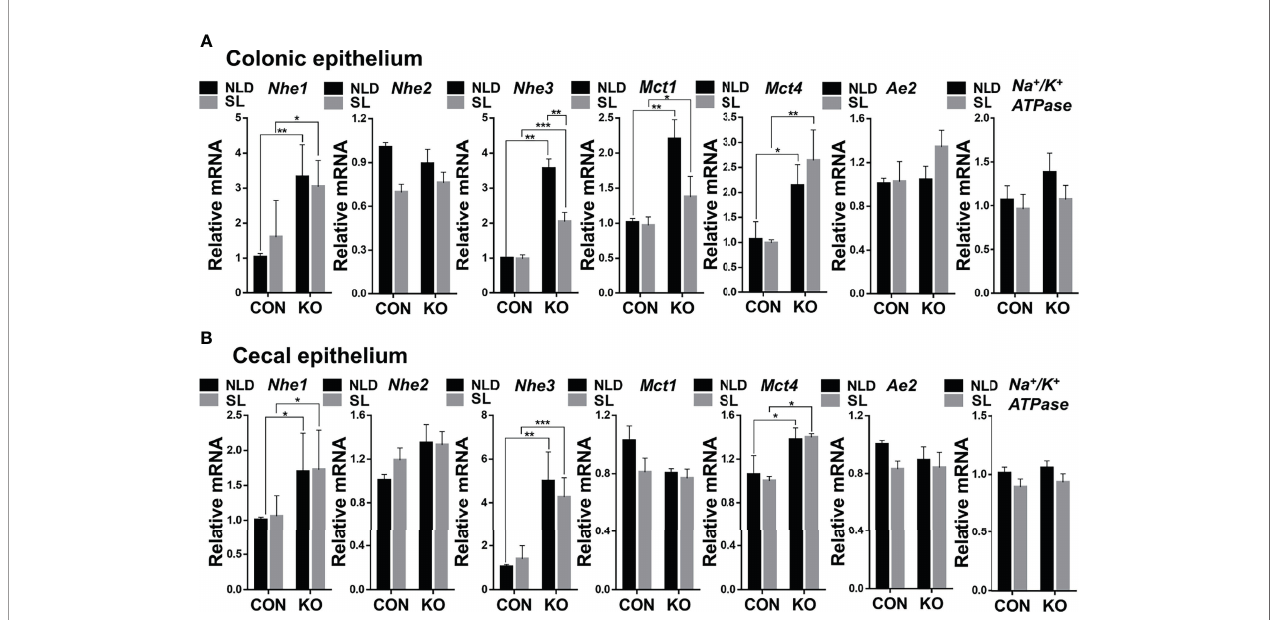
FIGURE 3 | Relative expression of colonic and cecal epithelial SCFAs transporter genes in KO and CON mice under NLD and SL. KO, Per2 gene knockout ( Period2 − / − ) mice; CON, wild-type ( Period2 +/+ ) mice; NLD, normal light – dark cycle treatment of 12 h of light and 12 h of darkness; SL, short-light treatment of 8 h of light and 16 h of darkness. Representative charts of the expression levels of Nhe1 gene, Nhe2 gene, Nhe3 gene, Mct1 gene, Mct4 gene, Ae2 gene, and Na + /K + ATPase gene of colonic epithelium (A) and cecal epithelium (B) . Expressions of SCFAs transporter genes were determined in Per2 knockout and wild-type mice under NLD and SL by PCR method. Statistical analyses were conducted using two-way ANOVA. * p < 0.05, signi fi cant difference; ** or *** p < 0.01 or p < 0.001, extremely signi fi cant difference. Results are presented as means ± SEM (n = 6 per